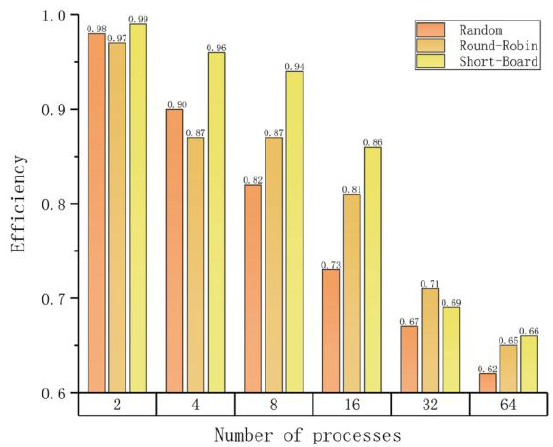
Figure 4. Load balancing efficiencies.